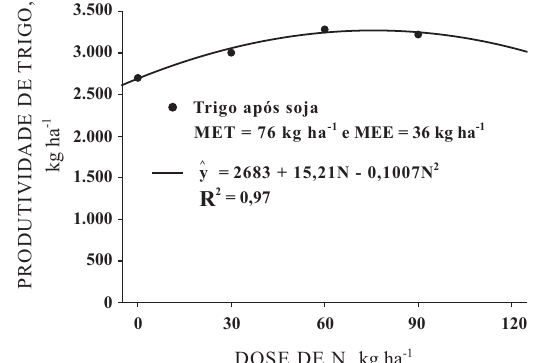
Figura 1. Produtividade de trigo após soja ((I1 2003 + I1 2004 + I2 2004)/3), como variável de doses de N aplicadas, máxima eficiência técnica (MET) e máxima eficiência econômica